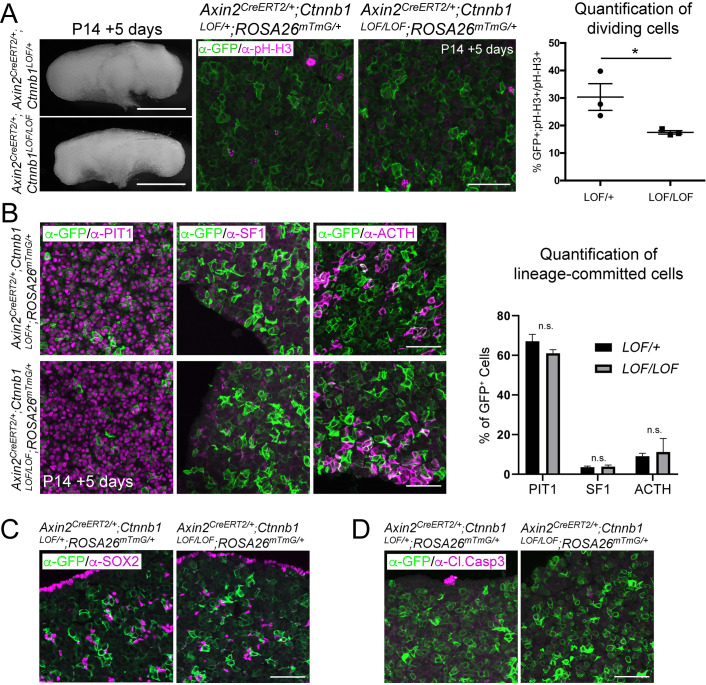
Axin2 expressing cells contribute to pituitary growth and expansion of all lineages.(A) Dorsal wholemount view of Axin2CreERT2/+; Ctnnb1LOF/+;ROSA26mTmG/+ and Axin2CreERT2/+; Ctnnb1LOF/LOF;ROSA26mTmG/+ pituitaries induced at P14 and lineage traced for 5 days. Scale bars: 500 μm. Immunofluorescence staining against GFP (green) and pH-H3 (magenta) in Axin2CreERT2/+; Ctnnb1LOF/+;ROSA26mTmG/+ and Axin2CreERT2/+; Ctnnb1LOF/LOF;ROSA26mTmG/+ pituitaries. Scale bar: 50 µm. Quantification of the contribution of lineage traced cells in control and mutants. Each data point represents the mean from one individual. p=0.0313, unpaired t-test (n = 3). (B) Immunofluorescence staining against GFP (green) and PIT1, SF1, and ACTH (magenta) in Axin2CreERT2/+; Ctnnb1LOF/+;ROSA26mTmG/+ and Axin2CreERT2/+;Ctnnb1LOF/LOF;ROSA26mTmG/+ pituitaries induced at P14 and lineage traced for 5 days. Quantification of the percentage of GFP+ cells, double-positive for each of the lineage markers, showing no significant changes for each lineage between controls and mutants (unpaired t-test, PIT1 p=0.1729, SF1 p=0.9488, ACTH p=0.6186. n = 4 controls, two mutants). Scale bars: 50 µm. (C) Immunofluorescence against GFP (green) and SOX2 (magenta) in Axin2CreERT2/+; Ctnnb1LOF/+;ROSA26mTmG/+ and Axin2CreERT2/+;Ctnnb1LOF/LOF;ROSA26mTmG/+ induced at P14 and lineage traced for 5 days (n = 4 controls, two mutants). Scale bars: 50 µm. (D) Immunofluorescence against GFP (green) and Cleaved Caspase-3 (magenta) in Axin2CreERT2/+; Ctnnb1LOF/+;ROSA26mTmG/+ and Axin2CreERT2/+;Ctnnb1LOF/LOF;ROSA26mTmG/+ induced at P14 and lineage traced for 5 days (n = 4 controls, two mutants). Scale bars: 50 μm.